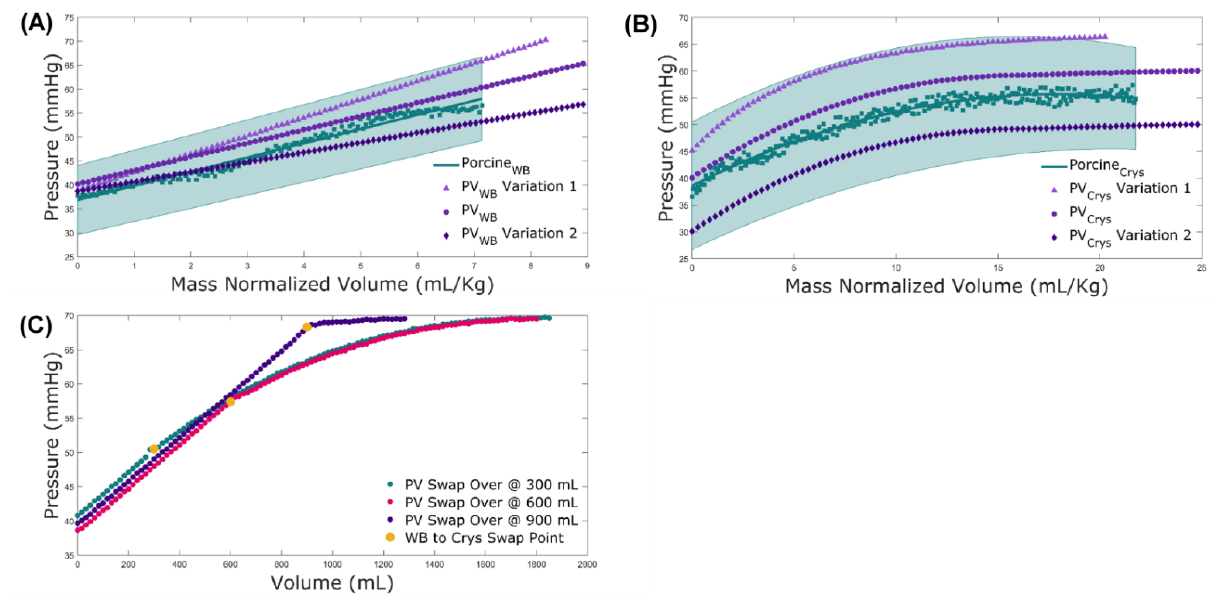
Figure 4. PhysioVessel Characterization. Pressure-volume testing results for (A) WB and (B) crystalloid PhysioVessels. Results are shown for base models and two PhysioVessel variations to highlight how subject variability can be introduced. Corresponding infusion data from swine for each infusate type are plotted with the regression curve fit of the data and a ±1 SD shaded region. (C) Switch-over test results with a PV WB infusion of 300 mL, 600 mL, or 900 mL followed by a transition to PV Crys until reaching target pressure (68 mmHg). Transition points between the two vessels are identified by yellow markers.